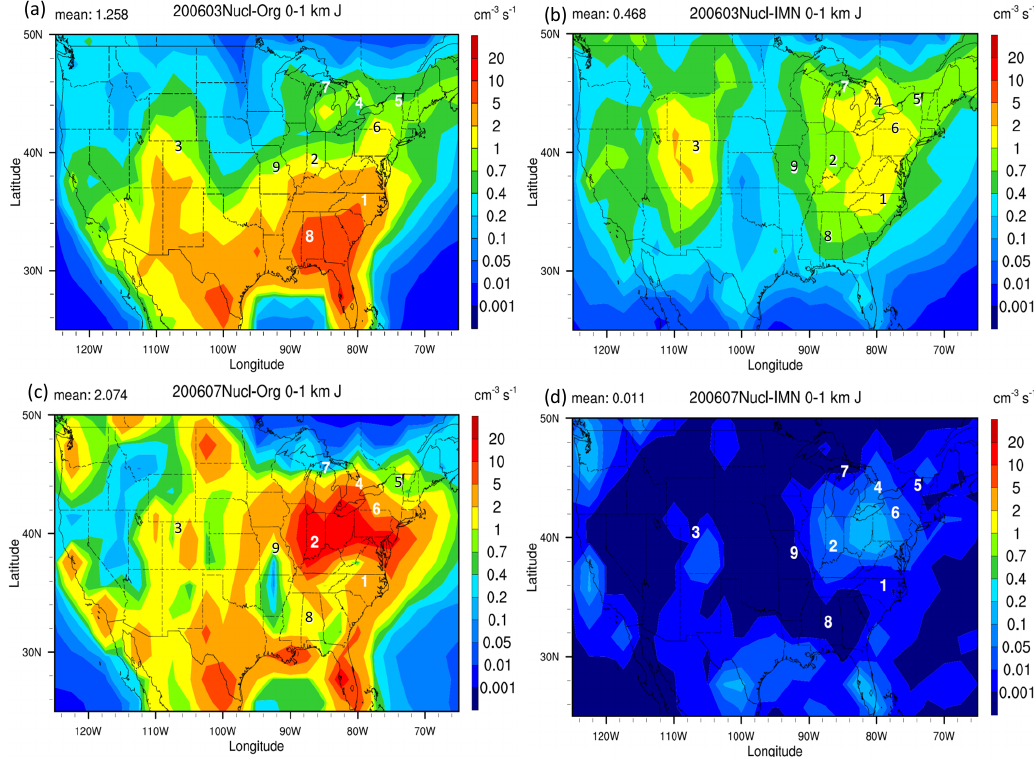
Figure 2. Horizontal distributions of monthly mean nucleation rates ( J ) in the boundary layer (0–1km above surface) in March (a, b) and July (c, d) of 2006 based on two different nucleation schemes, i.e., Nucl-Org (a, c) and Nucl-IMN (b, d) (see text for details). The locations of sites 1–9 (Table 1) are